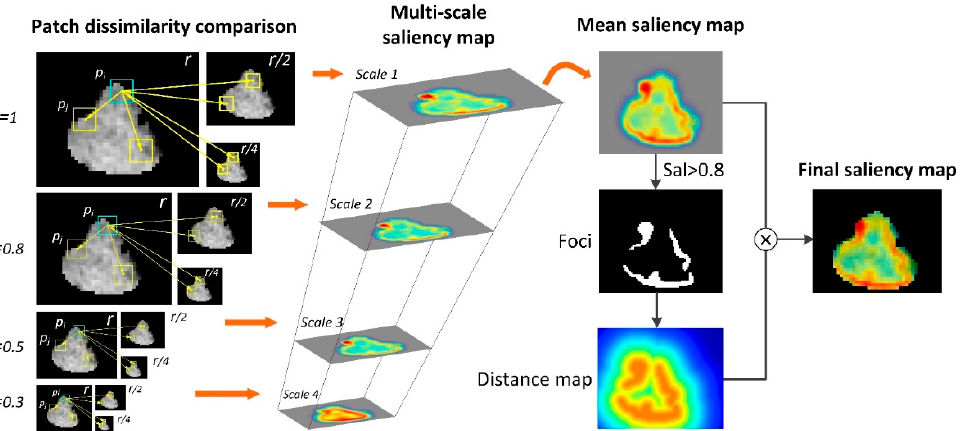
Figure 2. Schematic illustration of context-aware saliency map generation. Patch dissimilarity was compared in a multi-scale manner to generate a saliency map at each scale. The final saliency map was then constructed by multiplying mean saliency map and distance map.